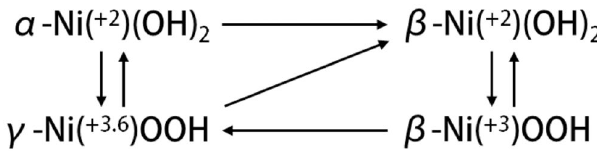
Figure 1. Phase transformation between different Ni(OH) 2 and NiOOH